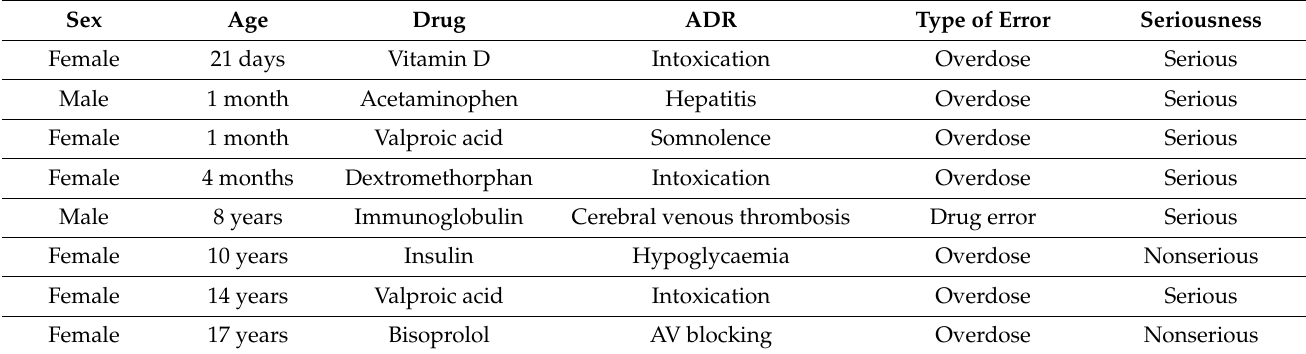
Table 3. Characteristics of adverse drug reactions (ADRs) due to medication errors.